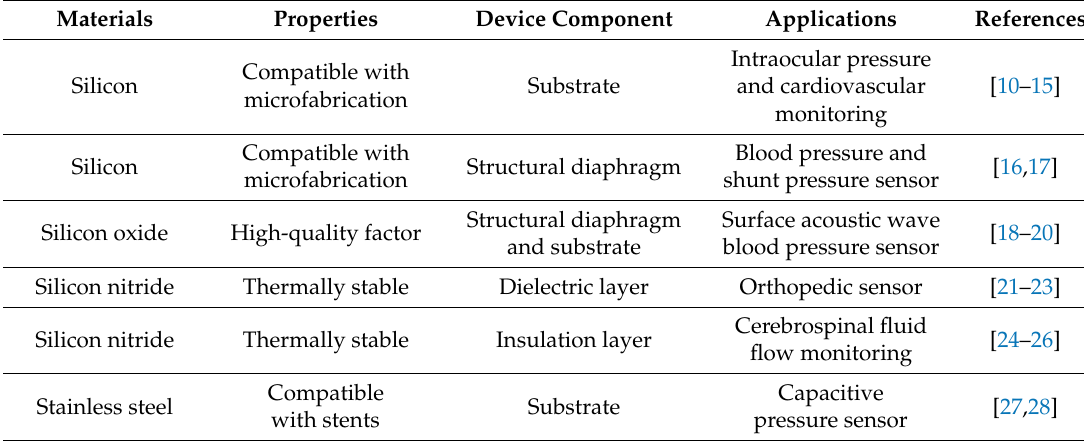
Table 1. A summary of the traditional materials with applications in implantable